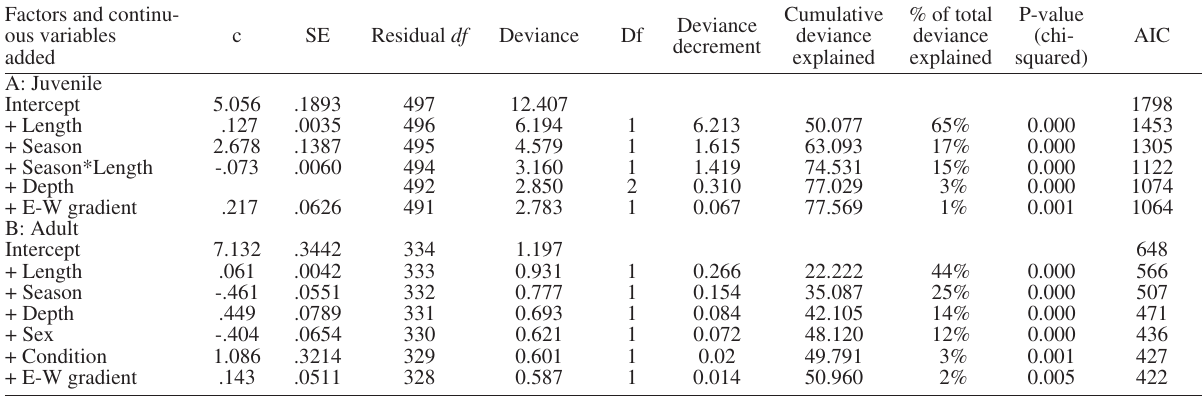
Table 5. – Stepwise generalized linear model for factors and continuous variables controlling δ 15 N variability in juvenile (A) and adult (B) hakes in the GoL. Parameter estimates (c) and standard error for the best fitting GLMs model. Factors and continu- ous